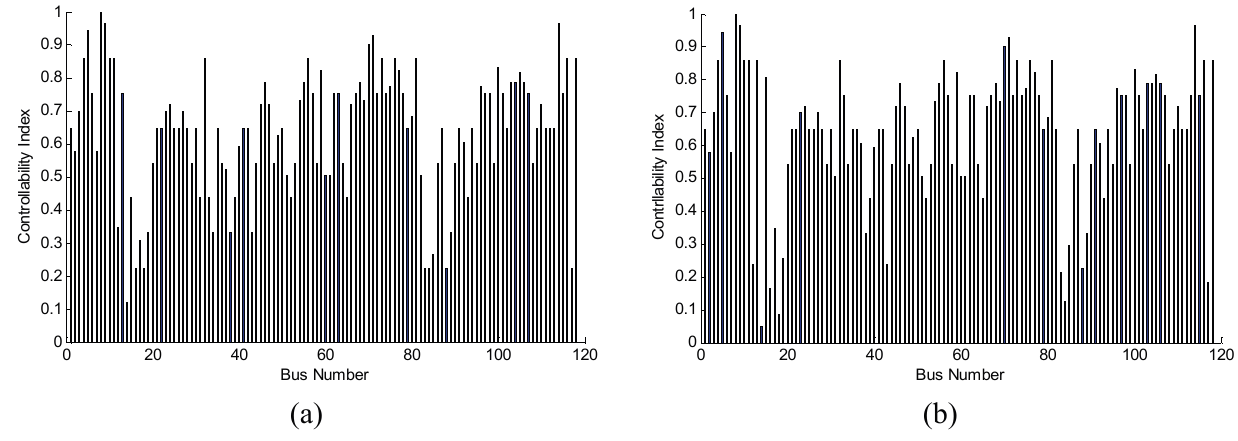
Figure 7. Effect of random attacks on controllability index distribution. ( a ) Original distribution; ( b ) Distribution after five random